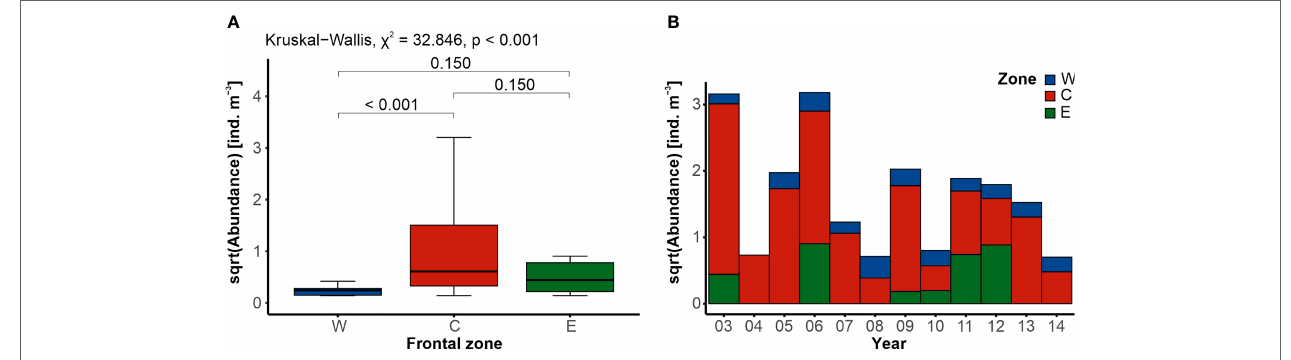
FIGURE 4 | Differences in the abundance of gelatinous zooplankton. (A) Comparison of the average abundance between the three frontal zones (western W, blue; central C, red; and eastern E, green), with the results of statistical tests (Kruskal–Wallis followed by Dunn’s post hoc ). (B) Interannual trend in the abundance within the frontal zones.